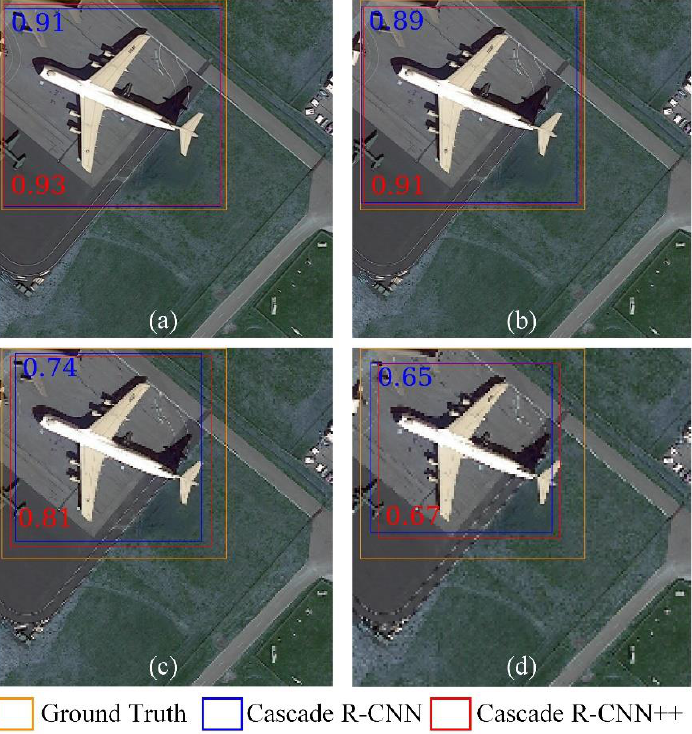
Figure 7. Examples of single object detection across different resolution remote sensing images with ( a ) no upscale and upscaled by factors ( b ) two, ( c ) three, and ( d ) four, with marked up IoU values of regressed bounding boxes by Cascade R-CNN and Cascade R-CNN++.